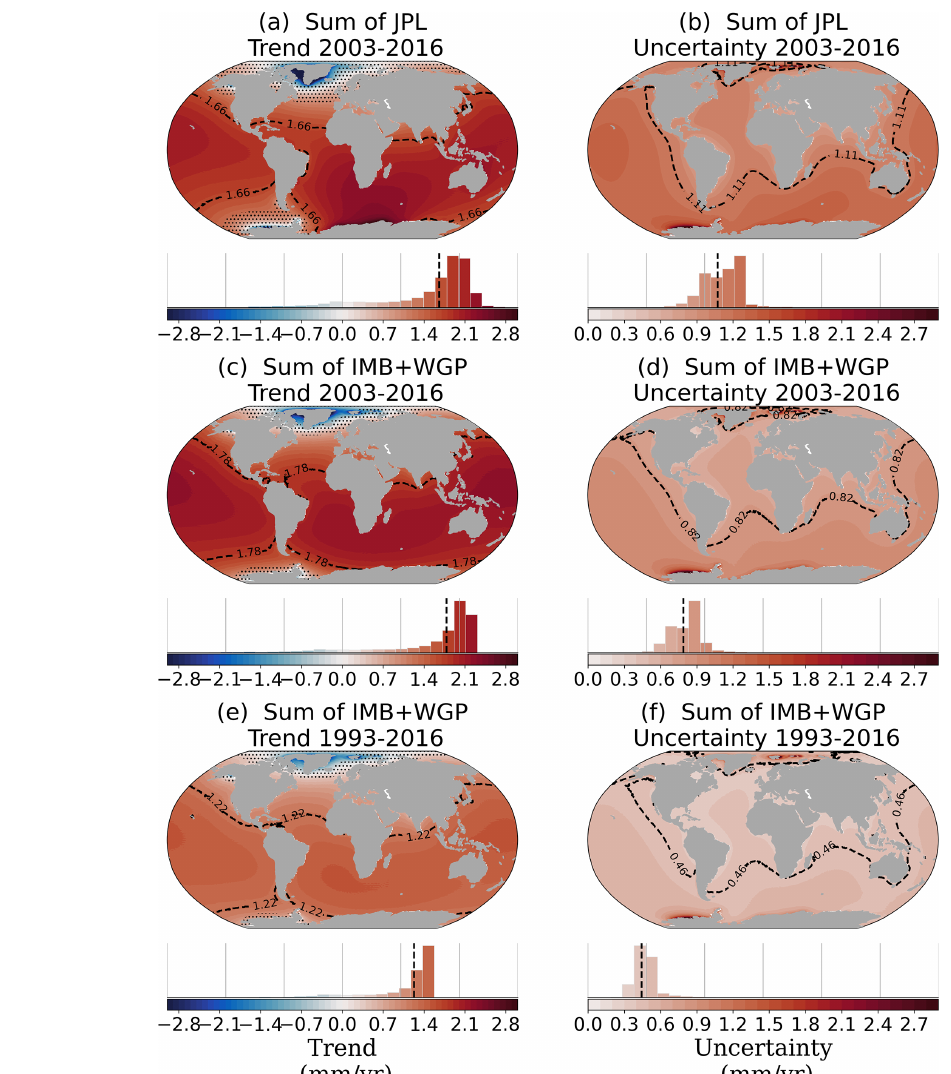
Figure 7. Total GRD-induced SLC fields of the trend and uncertainty (mmyr − 1 ) (AIS+GIS+LWS+Glaciers contributions; intrinsic + tempo- ral + spatial uncertainties) for GRACE (a, b) and IMBIE+WaterGAP for 2003–2016 (c, d) and for 1993–2016 (e, f) . Histograms underneath each map indicate the distribution of the regional values across the oceans, on which the 5th to 95th percentile range (90% range) is based. Spatial average of the regional trend and uncertainty indicated by black dashed lines in the maps and bar charts. Regions with trends smaller than the 1-sigma uncertainty are indicated in the map with